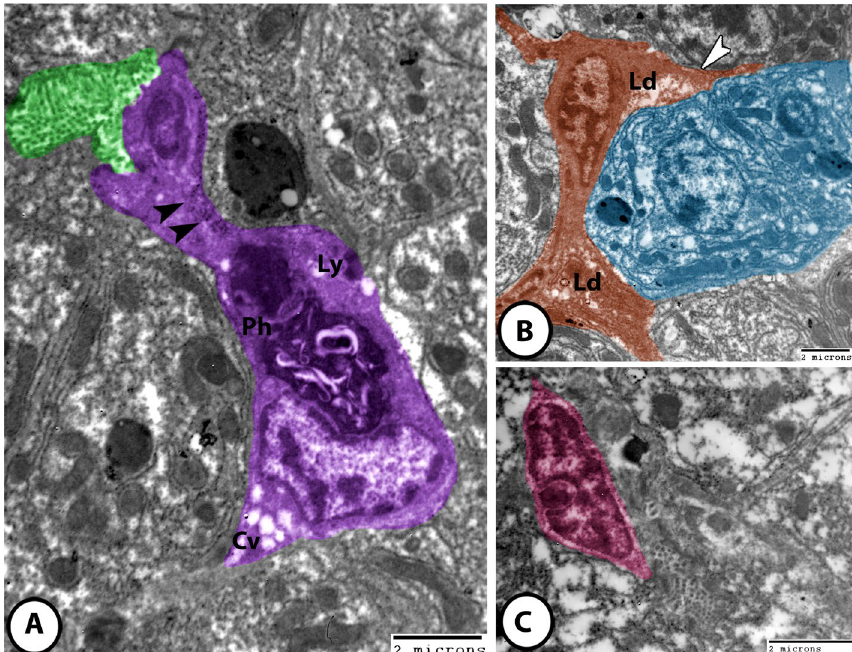
Fig. 7 Digitally colored TEM images of the liver in molly fish. A Melanomacrophage center (purple) contained phagosomes (Ph), many lysosomes (Ly), cytoplasmic vacuoles (Cv), and melanin pigments (arrowheads). Note the bile canaliculi (green) located near the melanomacrophage center. B Ito cell (brown) intercalated between hepatocytes (blue). Note that Ito cell showed cytoplasmic processes (arrowhead) and lipid droplets (Ld). C Kupffer cells (pink) with their characteristic indented heterochromatic